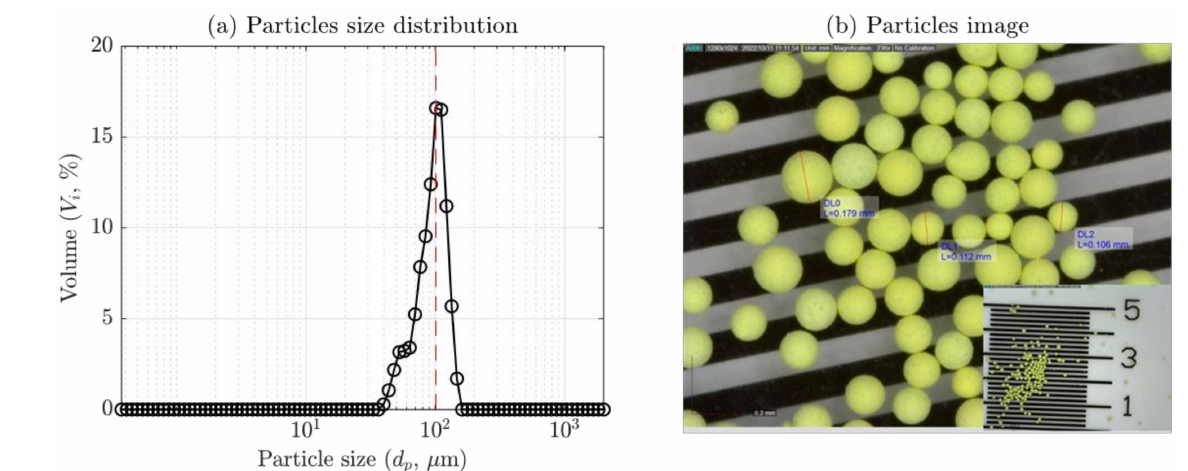
Figure 1. Particle size distribution ( a ) and an image ( b ) of the GMC-Y3 catalyst.